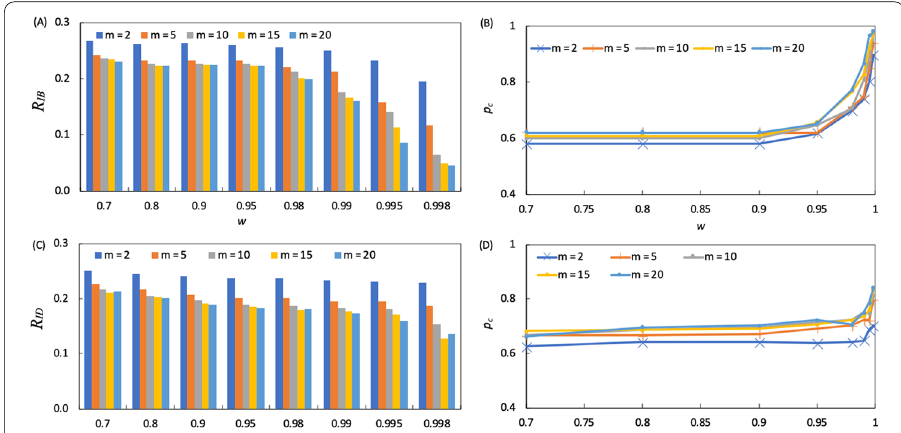
Fig. 8 Robustness measures of simulation result for the modular networks generated from BA network with 4 with different value of rewiring probability w and for different number of modules m in N 10,000, (cid:31) k (cid:30) = = the network: A , C the single value network robustness ( R ) and B , D the critical occupation probability p c as a function of the re‑wiring ratio w for different node average degree (cid:31) k (cid:30) for IB and ID strategies, respectively. All results are averaged over 100